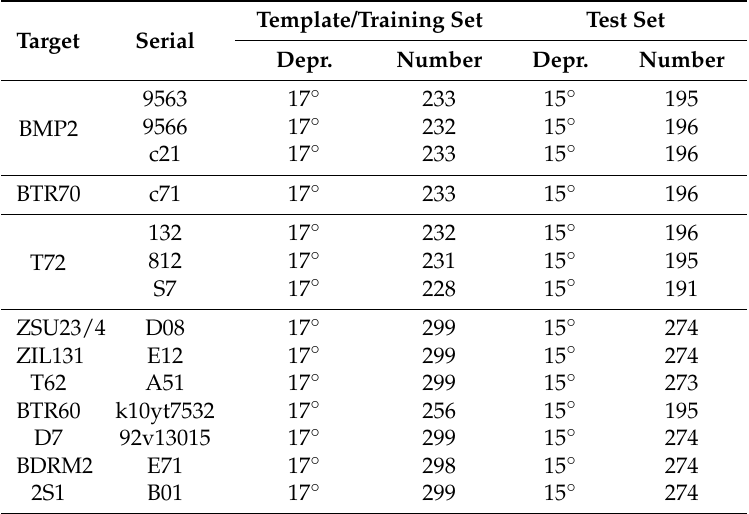
Table 1. The template/training and test sets for the